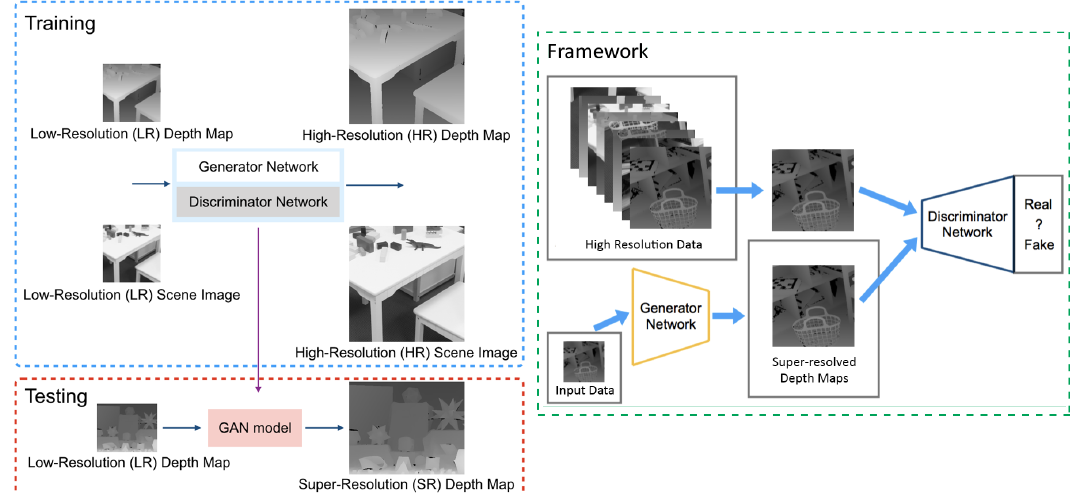
Figure 1. Overview of our proposed framework for depth map super-resolution.